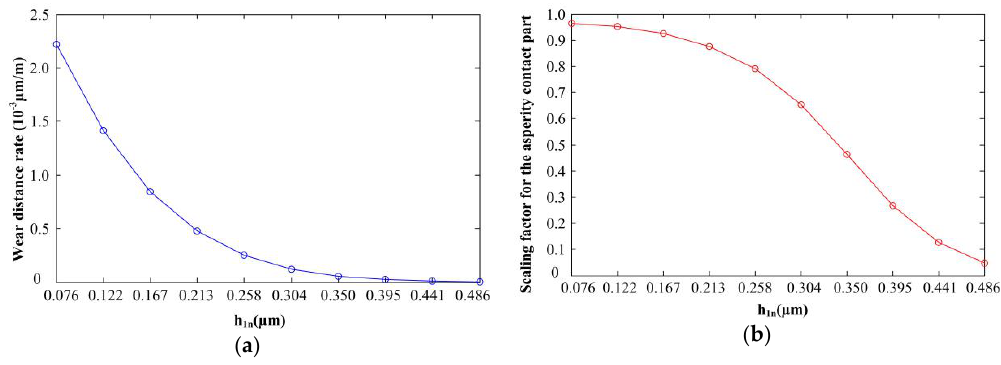
Figure 11. ( a ) Wear distance rate of the Gaussian surfaces for different thicknesses of the tapered film; ( b ) scaling factor for the asperity contact of the Gaussian surfaces for different thicknesses of the tapered film.